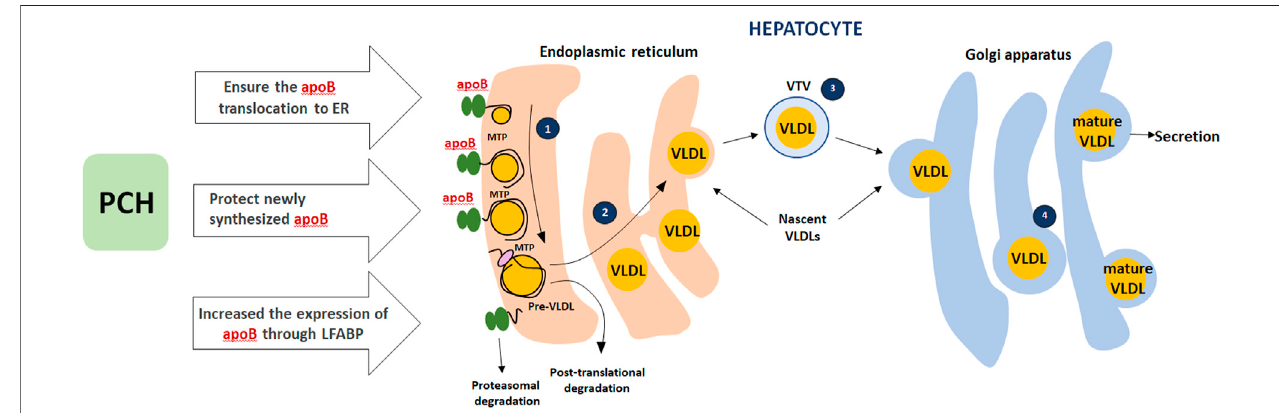
FIGURE 4 | Role of PCH in VLDLs secretion . (1) The assembly of VLDLs starts when apoB100 is translocated to the lumen of the endoplasmic reticulum (ER) and interacts with microsomal triglyceride transfer protein (MTP); *apoB100 that does not interact with MTP goes through proteasomal degradation. (2) MTP-dependent lipidation associated with pre-VLDL formation (pre-VLDL that is not converted to a mature lipoprotein will go through post-translational degradation). (3) Transport of nascent VLDLs to Golgi carried out using a specialized transport vesicle: the VLDL transport vesicle (VTV). (4) Then nascent VLDLs undergo a number of essential modi fi cations on the Golgi lumen (further VLDL lipidation). PCH plays a key role in apoB translocation to the ER, protects newly synthesized apoB, and increases apoB expression through